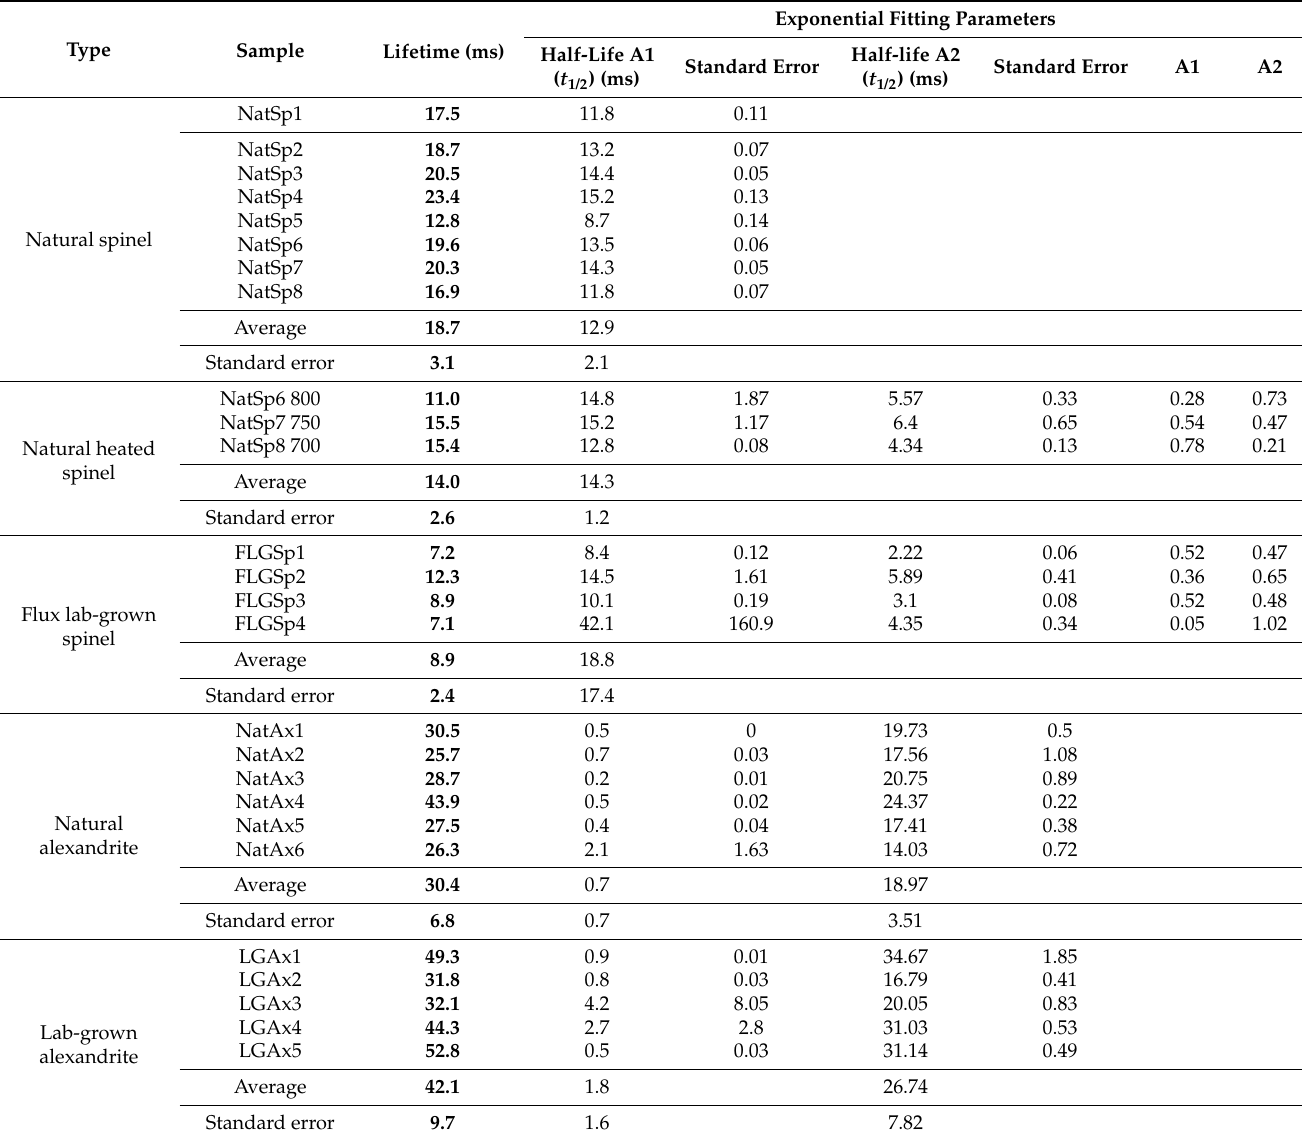
Table 2. Summary of the decay duration and exponential parameter half-life of the spinel and alexandrite samples. Half-life A1 ( t 1/2 ) and half-life A2 ( t 1/2 ) corresponded to the one-phase and two-phase exponential function fitting parameters, respectively. A1 and A2 are the coefficients to the exponential